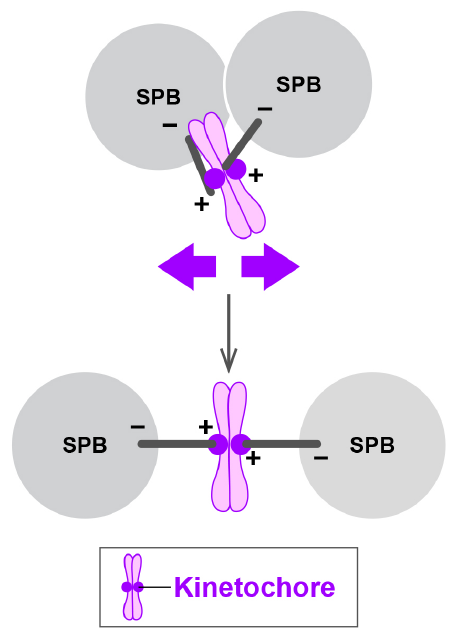
Figure 6. Outward force generation through the kinetochore and sister chromatid cohesion. The kinetochore and sister chromatid cohesion contribute to the generation of outward forces for SPB separation in mitosis. In the absence of Kinesin-5 and Kinesin-14, outward forces (purple arrows) derived from the kinetochore and/or sister chromatid cohesion are capable of separating the SPBs, thereby promoting bipolar spindle assembly [97]. + and – stand for the microtubule plus and minus ends,